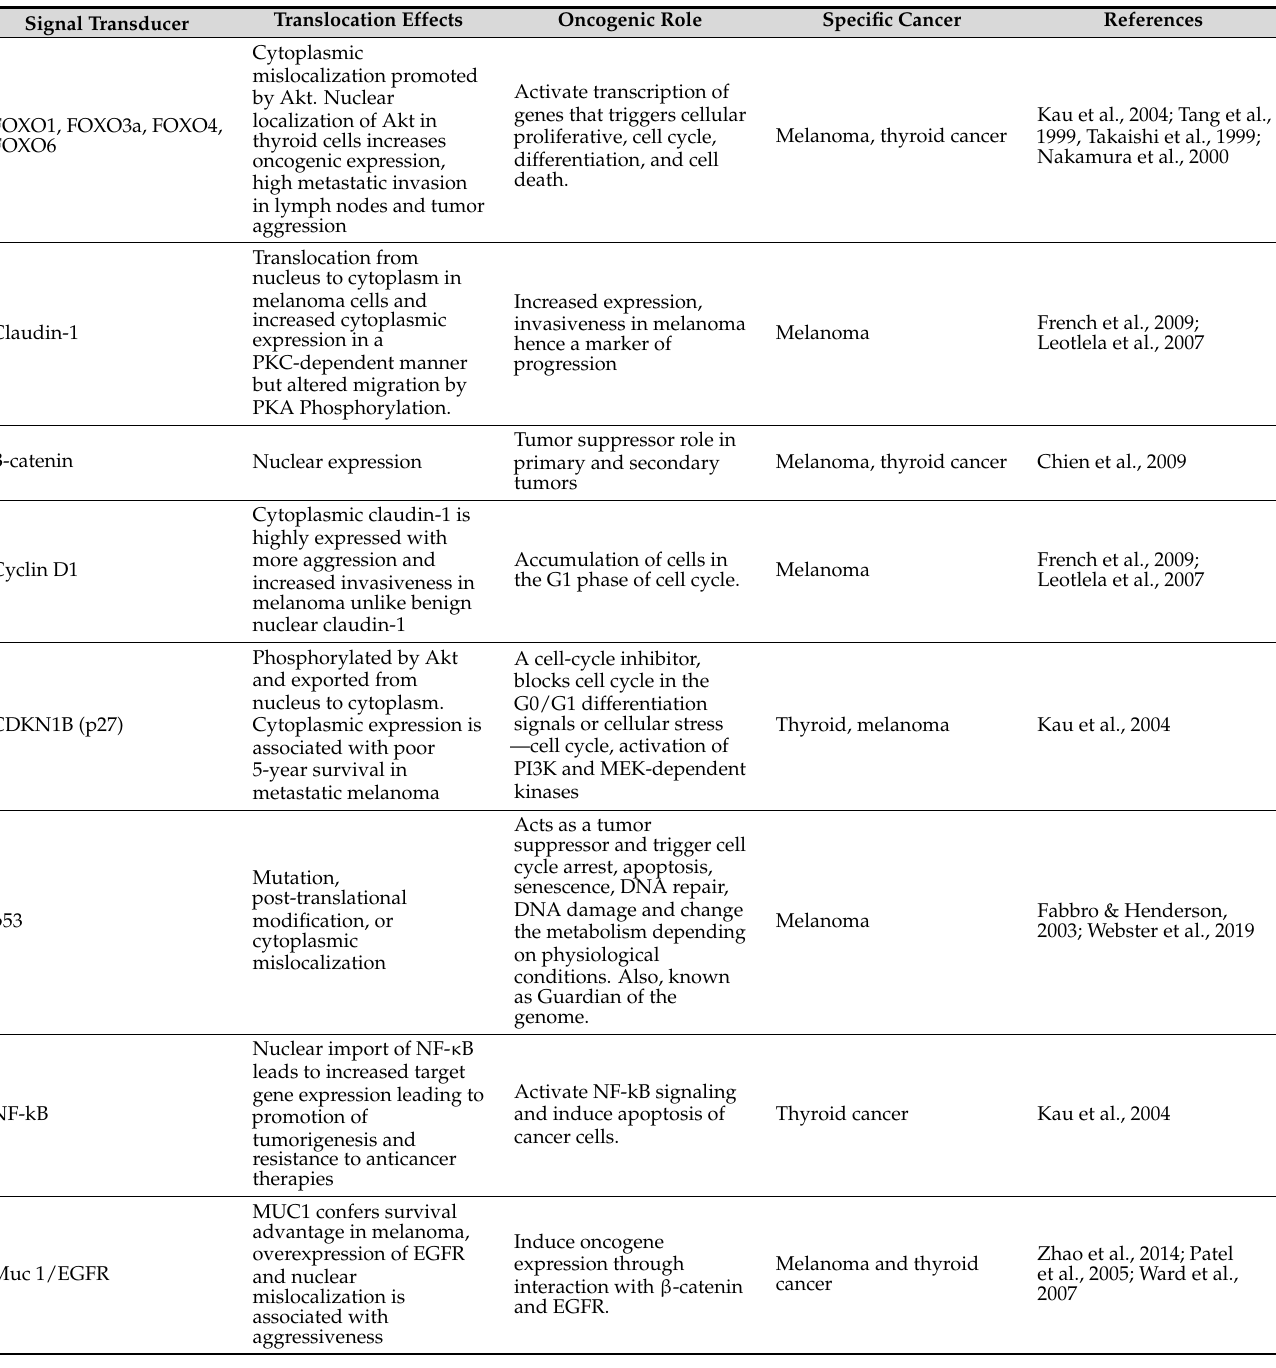
Table 2. Nucleocytoplasmic mechanisms of aggressive melanoma and thyroid